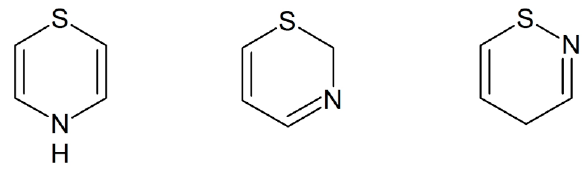
Figure 1. Structures of 1,4-, 1,3- and 1,2-thiazine.